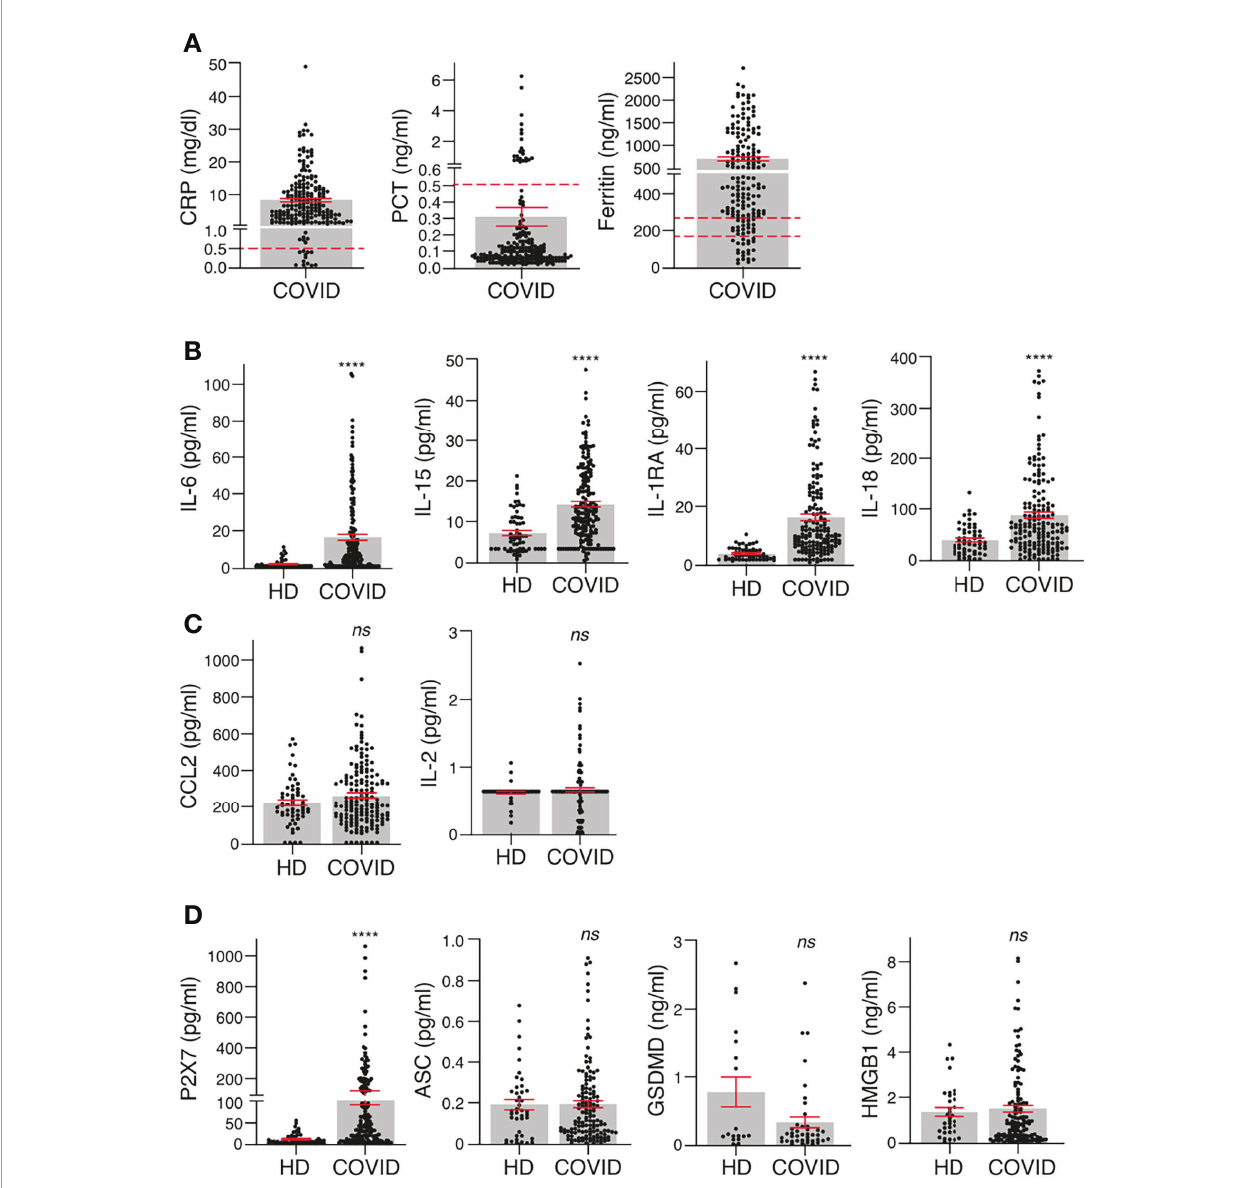
FIGURE 1 | In fl ammatory cytokines and biomarkers are markedly induced in COVID-19 patients. (A) Concentration of C-reactive protein (CRP), procalcitonin (PCT) and ferritin in plasma of COVID-19 patients. (B, C) Plasma concentrations of IL-6, IL-15, IL-1RA, IL18 (B) , CCL2 and IL-2 (C) in healthy donors (HD) and COVID-19 patients. (D) Plasma concentration of P2X7 receptor and markers of pyroptosis (ASC, GSDMD, and HMGB1) in healthy donors (HD) and COVID-19 patients. Each dot represents an individual patient; data are represented as mean (grey bars) ± sem. Dotted lines represent the normal range for each parameter analysed (the upper line in Ferritin ’ s graph corresponds to the normal range for healthy men and bottom line for healthy women). For (B – D) , **** p < 0.0001; ns , no signi fi cant difference (p > 0.05) with the Mann – Whitney